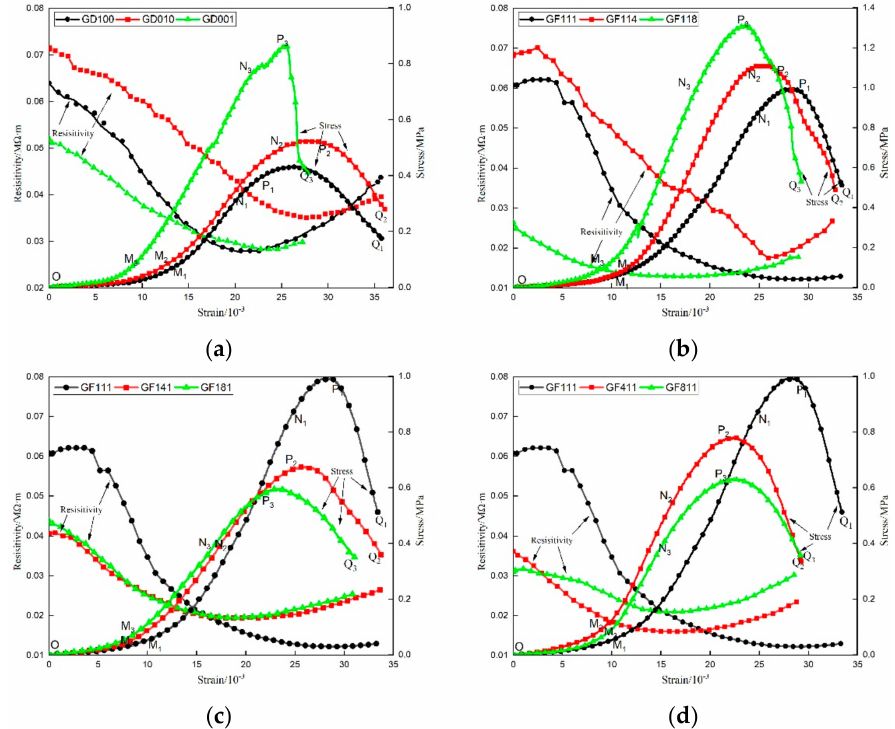
Figure 4. Stress–strain curves and resistivity–strain curves of tectonic coal samples with different particle sizes. ( a ) Curves of GD100, GD010, and GD001. ( b ) Curves of GF111, GF114, and GF118. ( c ) Curves of GF111, GF141, and GF181. ( d ) Curves of GF111, GF411, and